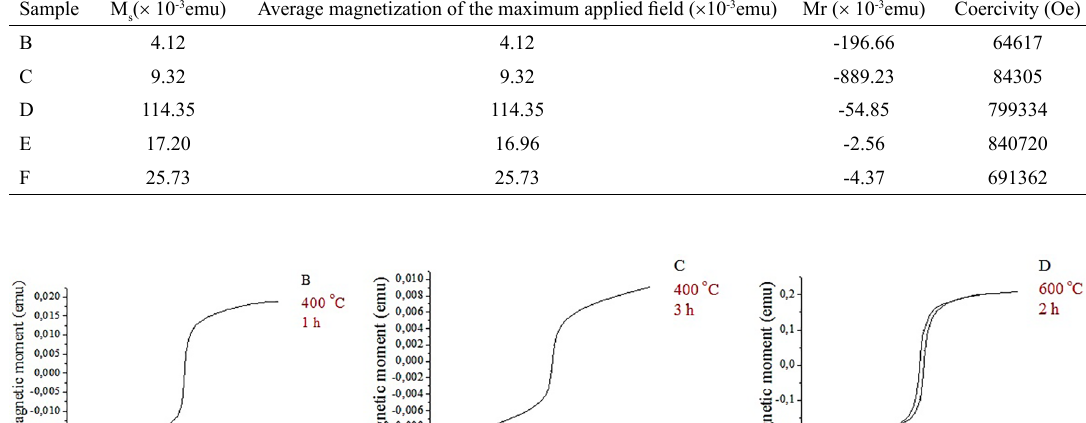
Table 2. Magnetometric analysis results of the samples treated in the CO2 atmosphere. Sample M ( × 10 -3 emu) s